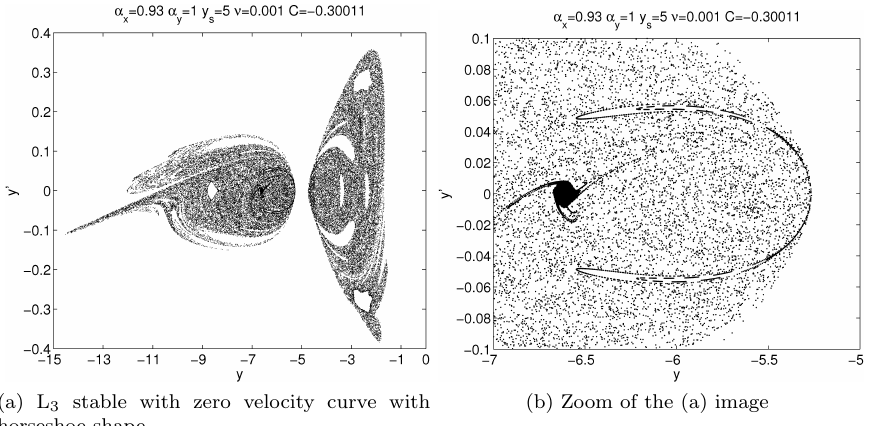
Fig. 6. Returns of the Poincar´e map with starting values on the y axis below the Lagrange point. L 3 is a stable equilibrium point and the zero velocity curve has a horseshoe shape around L 4 , L 3 and L 5 .